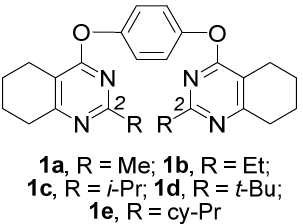
Figure 1. Allosteric modulators of AMPA receptor of bis(pyrimidine) series.